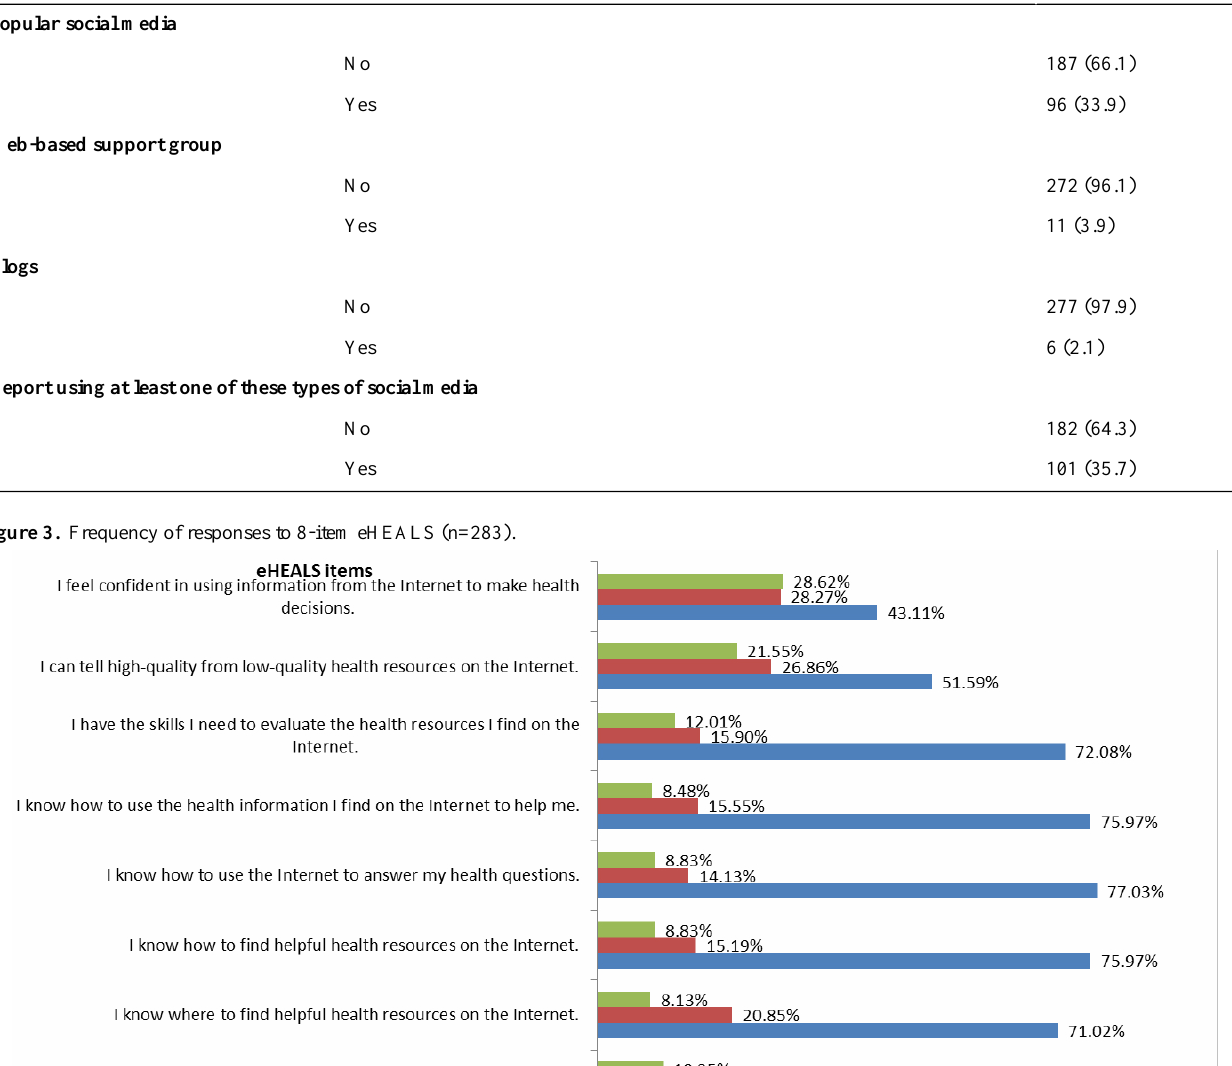
n (%)In last 12 months, have you used the Internet for any of the following reasons to locate or share health information?